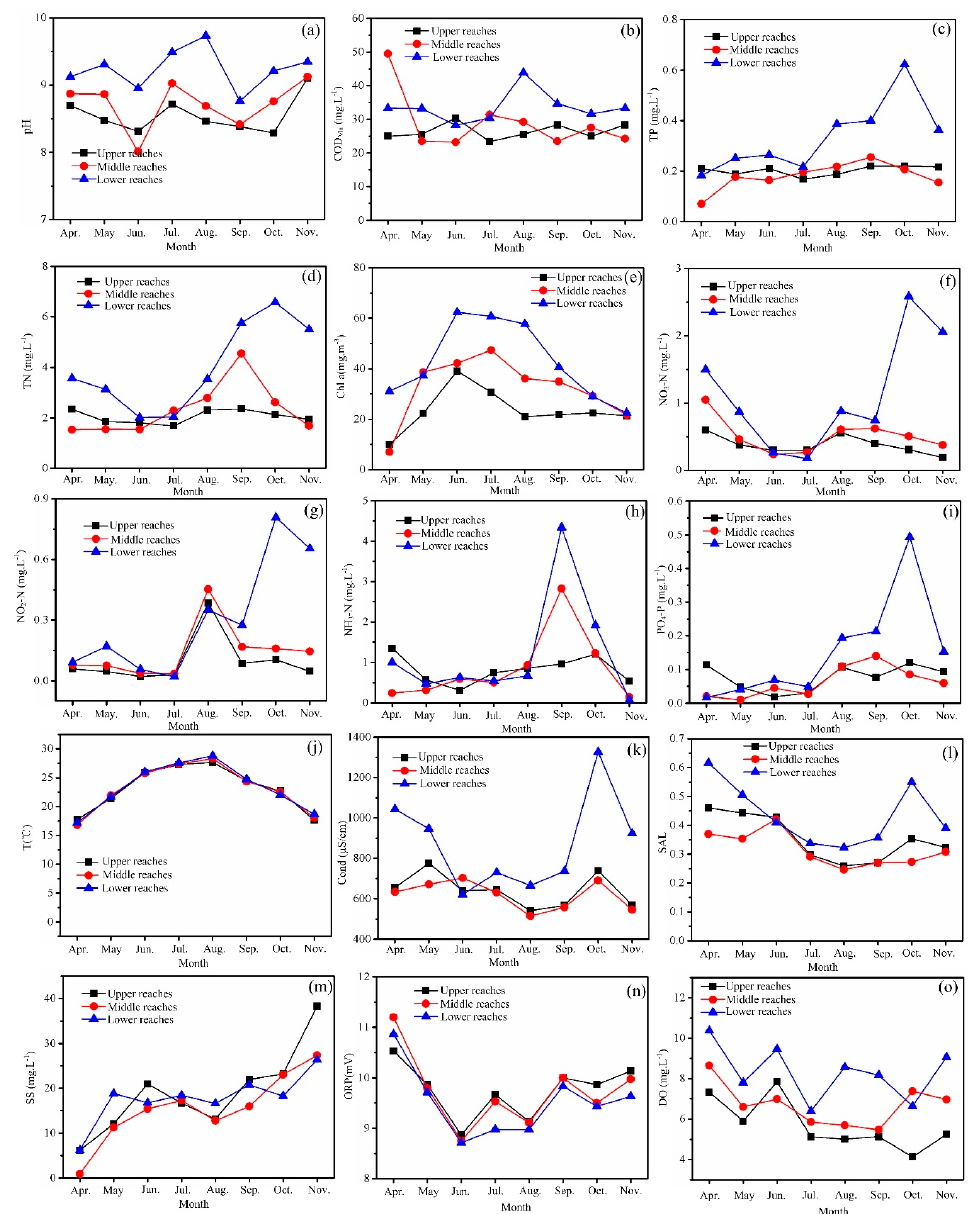
Figure 2. Spatial and temporal variations of environmental factors. The environmental factors are: ( a ) pH; ( b ) COD Mn ; ( c ) TP; ( d ) TN; ( e ) Chl a; ( f ) NO 3 -N; ( g ) NO 2 -N; ( h ) NH 3 -N; ( i ) PO 4 -P; ( j )